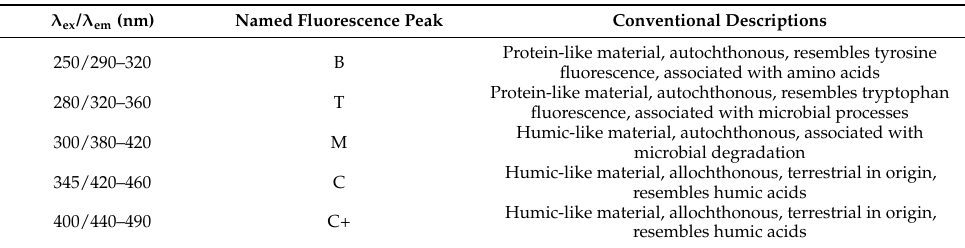
Table 1. Fluorescence peaks produced and identified from the overnight cultured environmental microbial community and environmental bacterial isolate